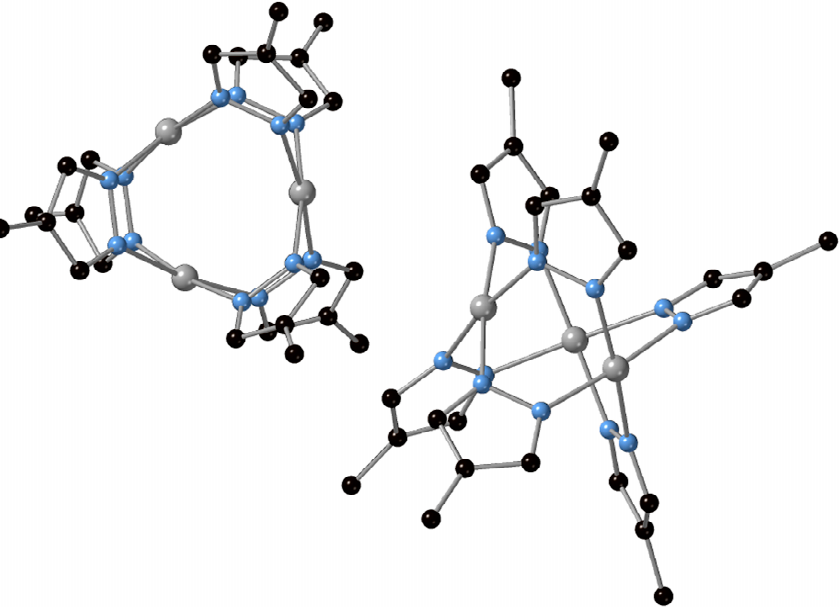
Figure 1. Two ball-and-stick views of the structure of 1 . Color code: C, black; N, blue; Pt, grey. H atoms are not shown for clarity.